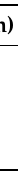
Figure 7. Atomic force microscope (AFM) test result: ( a ) Photograph of the surface; ( b ) Surface longitudinal photograph. Table 1. RMA value of the four samples.